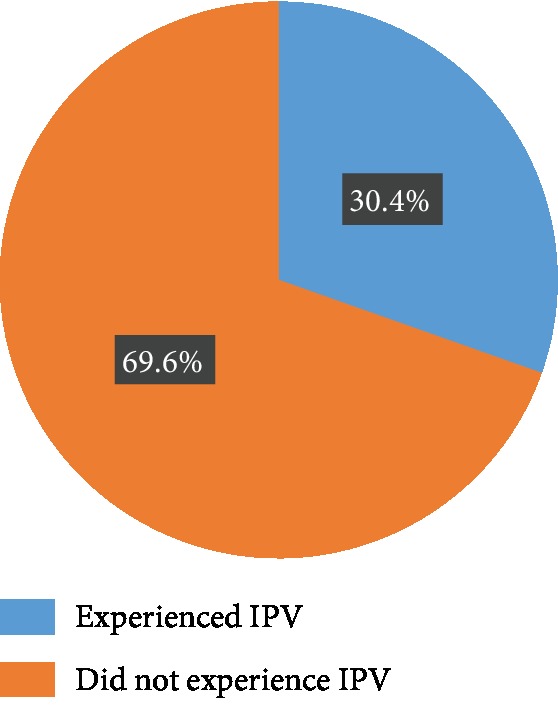
Lifetime prevalence of IPV during pregnancy.